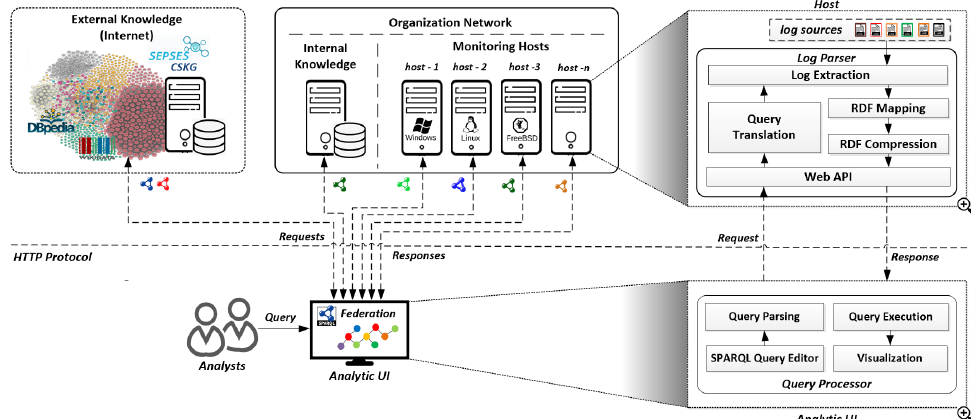
Figure 4. Virtual log graph and query federation